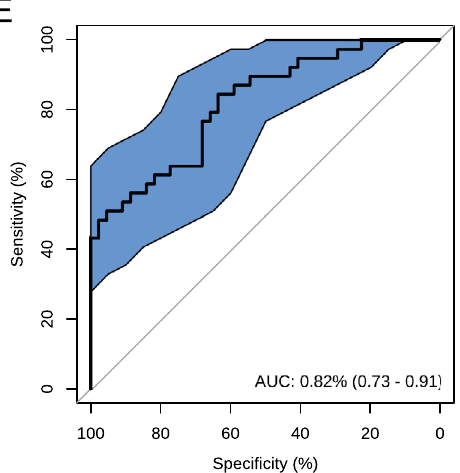
Figure 4. Correlations between biomarkers significantly different between AKI groups before or at the return from the theatre ( A ) and 24 h after surgery ( B ). ( C ) Predictive value of biomarkers that were significantly different before surgery. ( D ) Details of the logistic regression analysis. OD odds ratio. ( E ) ROC curve for a logistic model from ( D